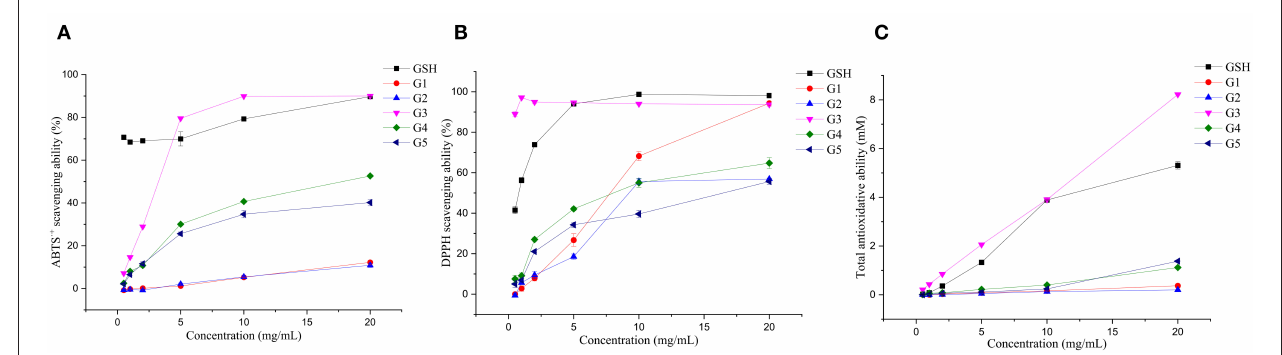
FIGURE 6 | Antioxidative capacities of the fractions isolated from UGSPH. ABTS •+ scavenging ability (A) , DPPH scavenging ability (B) , and total antioxidant ability (C)